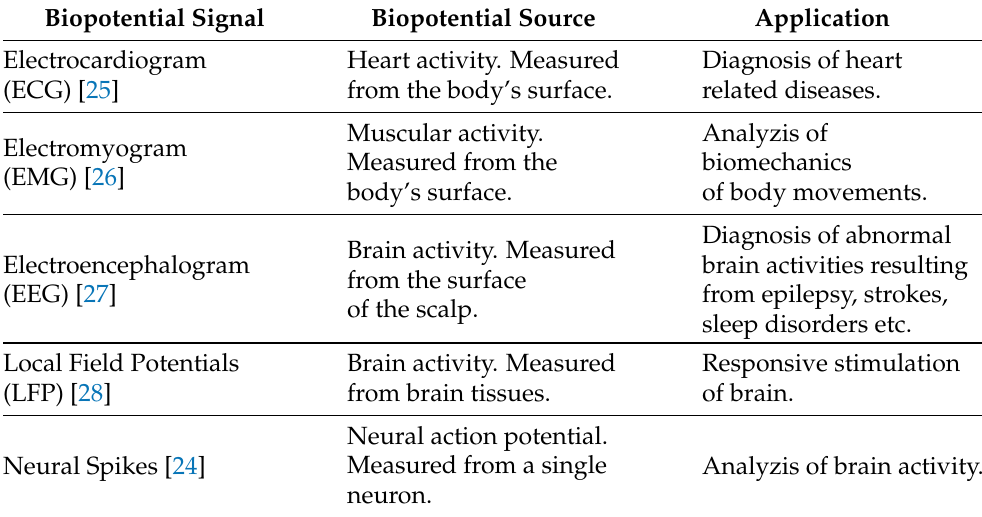
Table 1. Common biopotential signals, their sources and